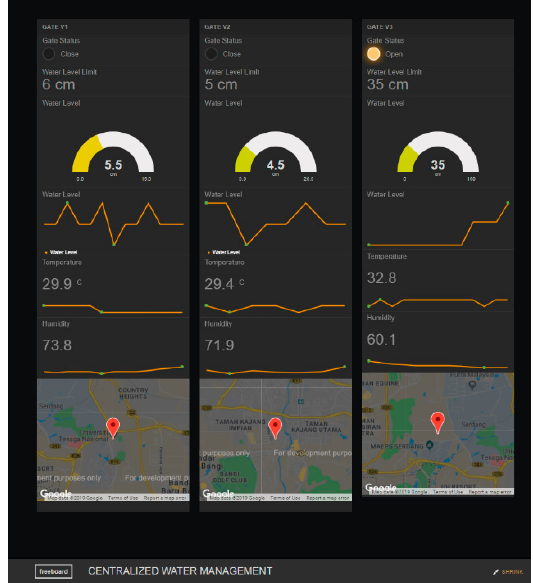
Figure 21. 2/3 of data completion from the IoT Client (Gate V1 stop updating).